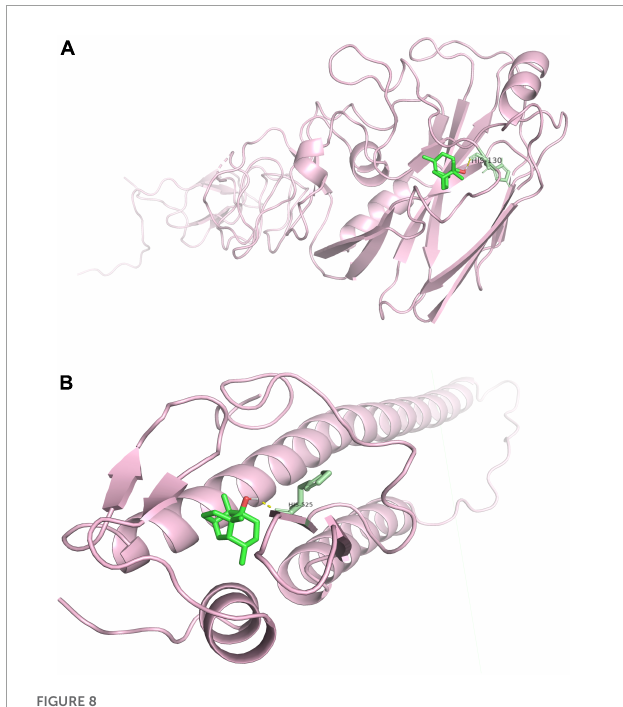
FIGURE8 Molecular interactions between Patchouli alcohol and